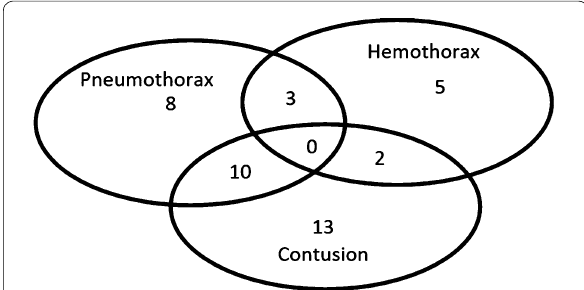
Fig. 1 The Venn diagram of the positive samples for pneumothorax, hemothorax and lung contusion detected by ultrasonography